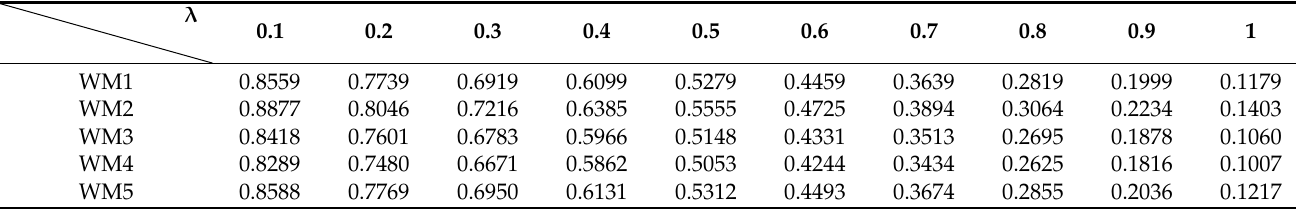
Table 8. Ranking of various λ attributes.